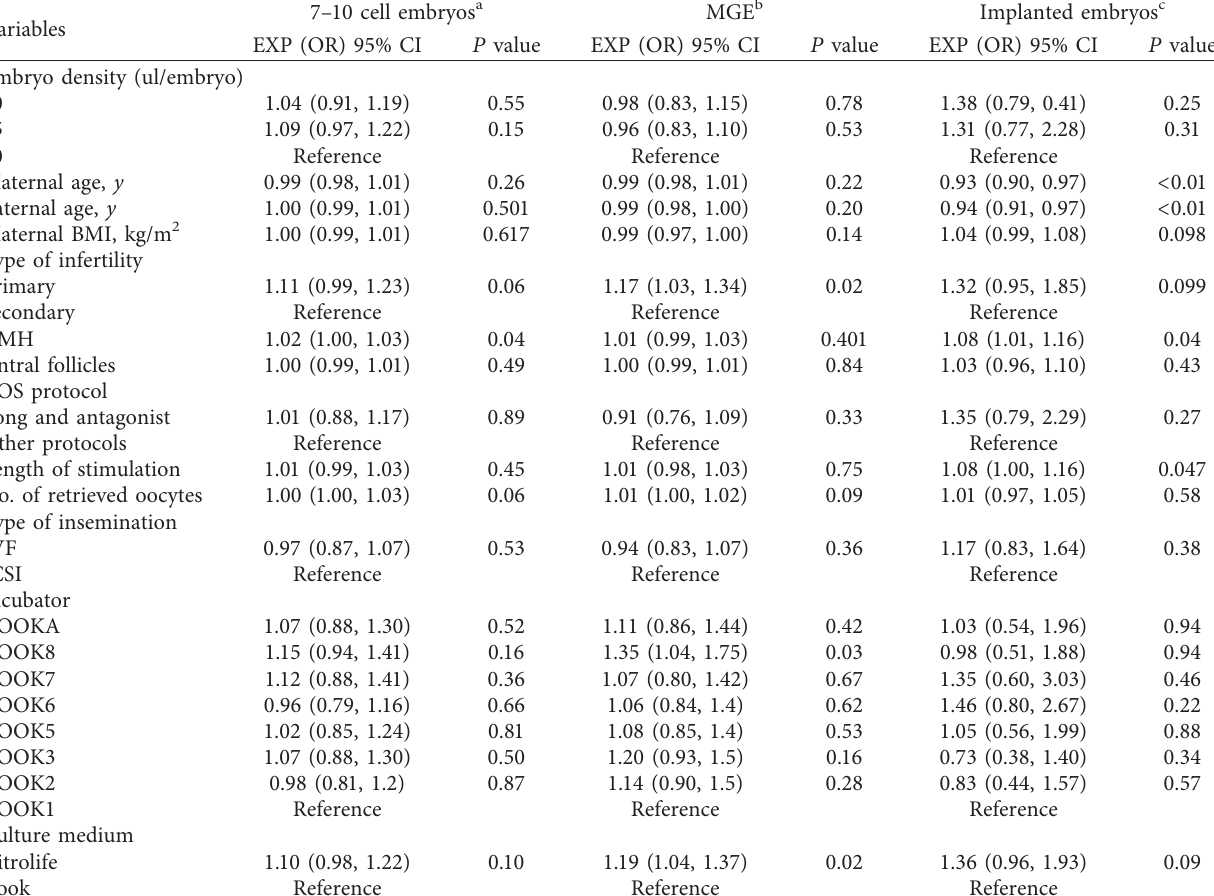
Table 3: Univariate analysis for cleaving speed, quality, and clinical results of day-3 embryos ∗